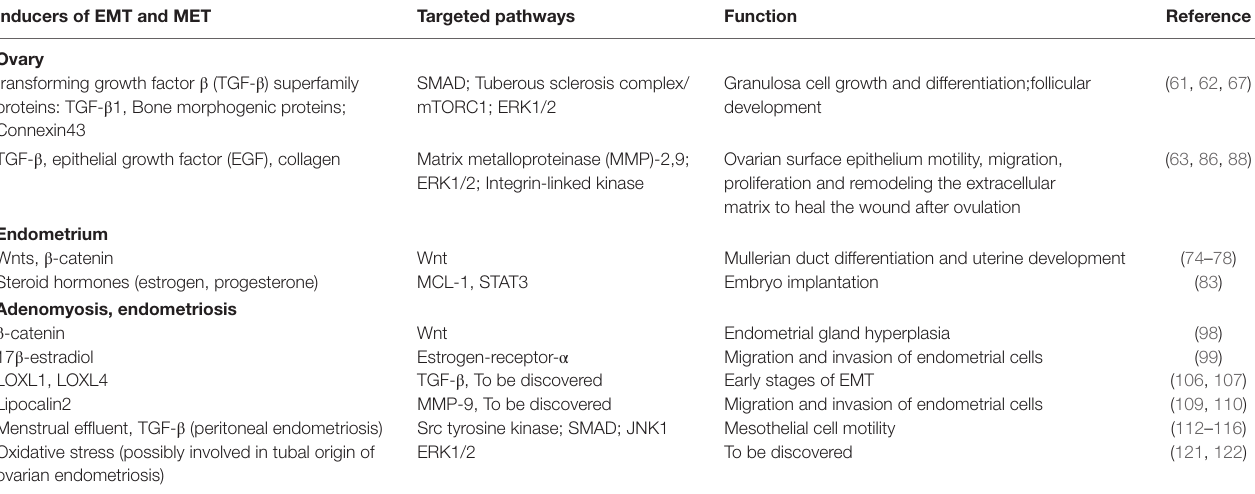
TAbLe 1 | Molecular and environmental inducers of non-cancerous epithelial-to-mesenchymal transition (EMT) and mesenchymal-to-epithelial transition (MET) in the female reproductive tract. inducers of eMT and MeT Targeted pathways Function Reference